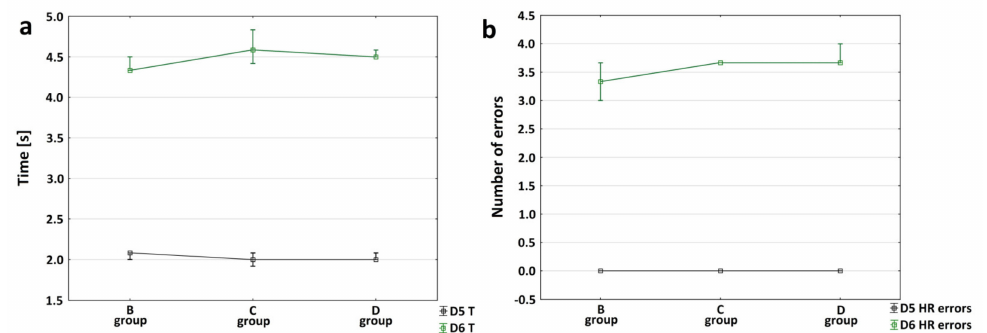
Figure 4. Comparison of the effects of an enlarged area of necrosis in the motor cortex on the level of mobility in rats after ischemic stroke; ( a ) the graph shows the median +/ − IQR of the mean time ( t ) taken by the different groups of rats (B, C and D) to pass over the slat on test Day 5 (D5) and Day 6 (D6); the Wilcoxon test shows that for each group (the time to cross the beam is statistically different between D5 and D6 ( p = 0.0431); ( b ) the graph shows the median +/ − IQR of the average number of right hindlimb errors (HR-errors) made by the rats while crossing the slat. Comparison of the number of errors between Day 5 (D5) and Day 6 (D6) within all time groups (Groups B, C and D): the Wilcoxon test shows that on Day (D6), for Groups B, C and D, the number of HR-errors was statistically significantly greater than on Day (D5) ( p =